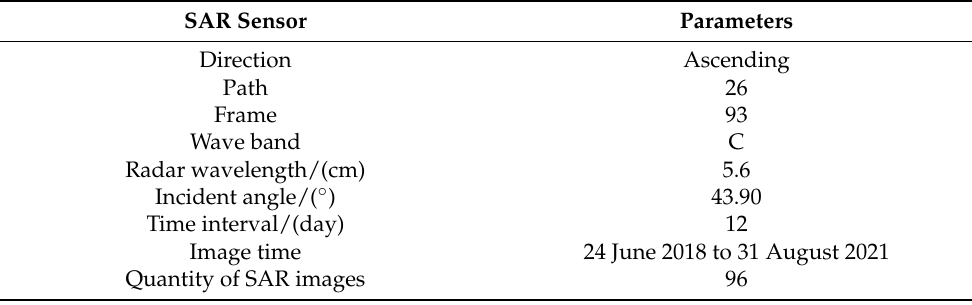
Table 1. The basic parameters of SAR image